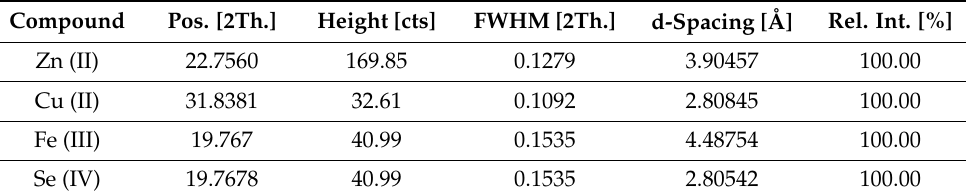
Table 5. XRD analysis data.